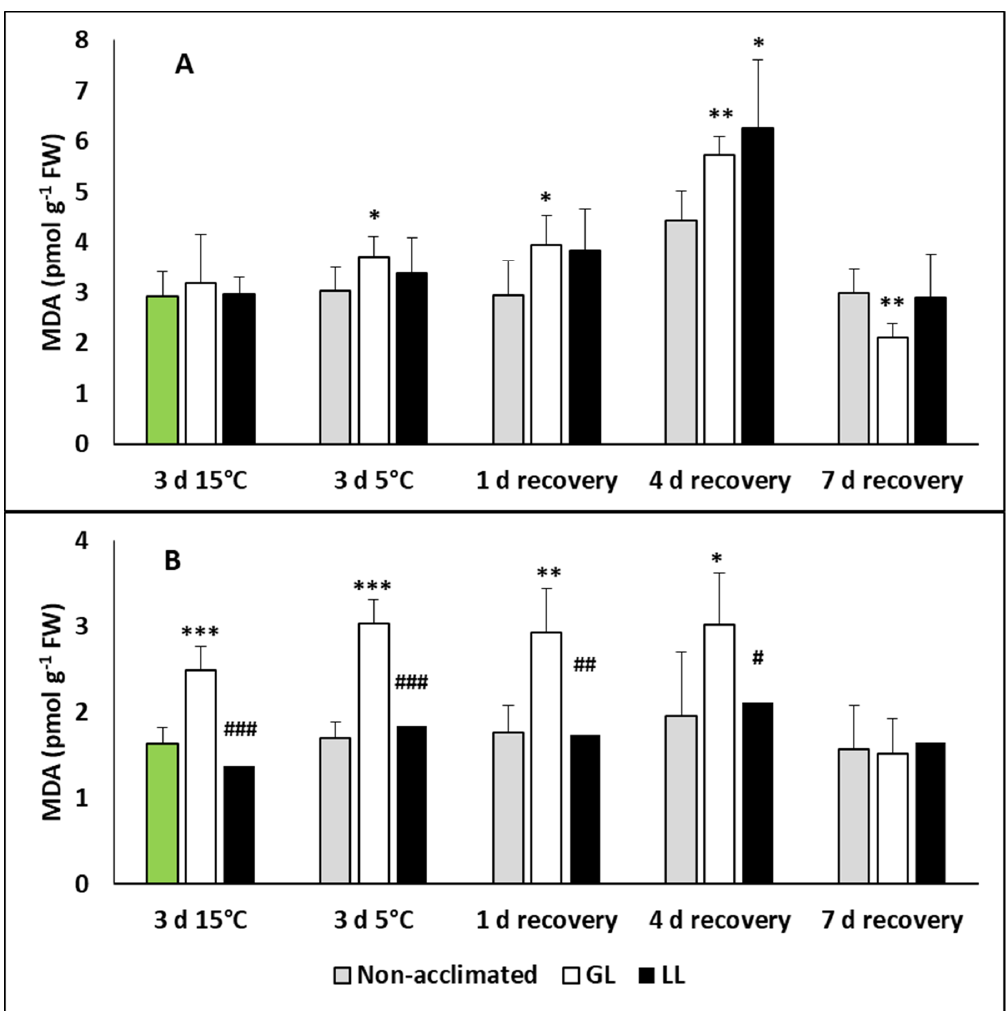
Figure 5. Changes in the malondialdehyde (MDA) contents during cold acclimation (15/13 °C), chilling (5 °C) and recovery in the leaves and roots of young maize plans: control plants (22/20 °C, 387 µmol m −2 s −1 ). Light intensities during hardening: GL: 387 µmol m −2 s −1 ; LL: 107 µmol m −2 s −1 . *, **, *** significant differences compared to the control plants on the same day at the p < 0.05, 0.01 and 0.001 levels, respectively. # , ## , ### significant differences compared to the GL plants on the same day at the p < 0.05, 0.01 and 0.001 levels, respectively. ( A : leaves; B : roots).